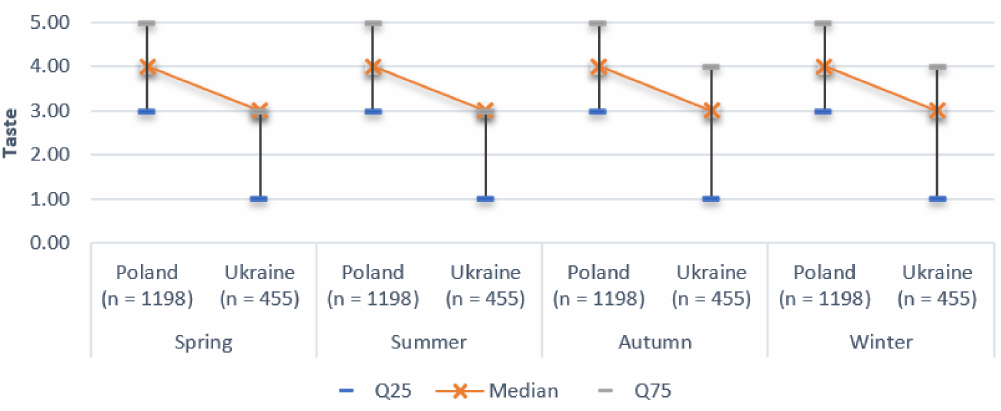
Figure 3. Evaluation of tap water taste during individual periods of the year by groups of respondents from Poland and